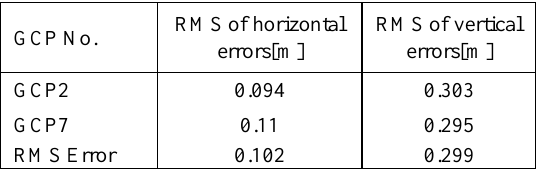
Table 2. Residual of check